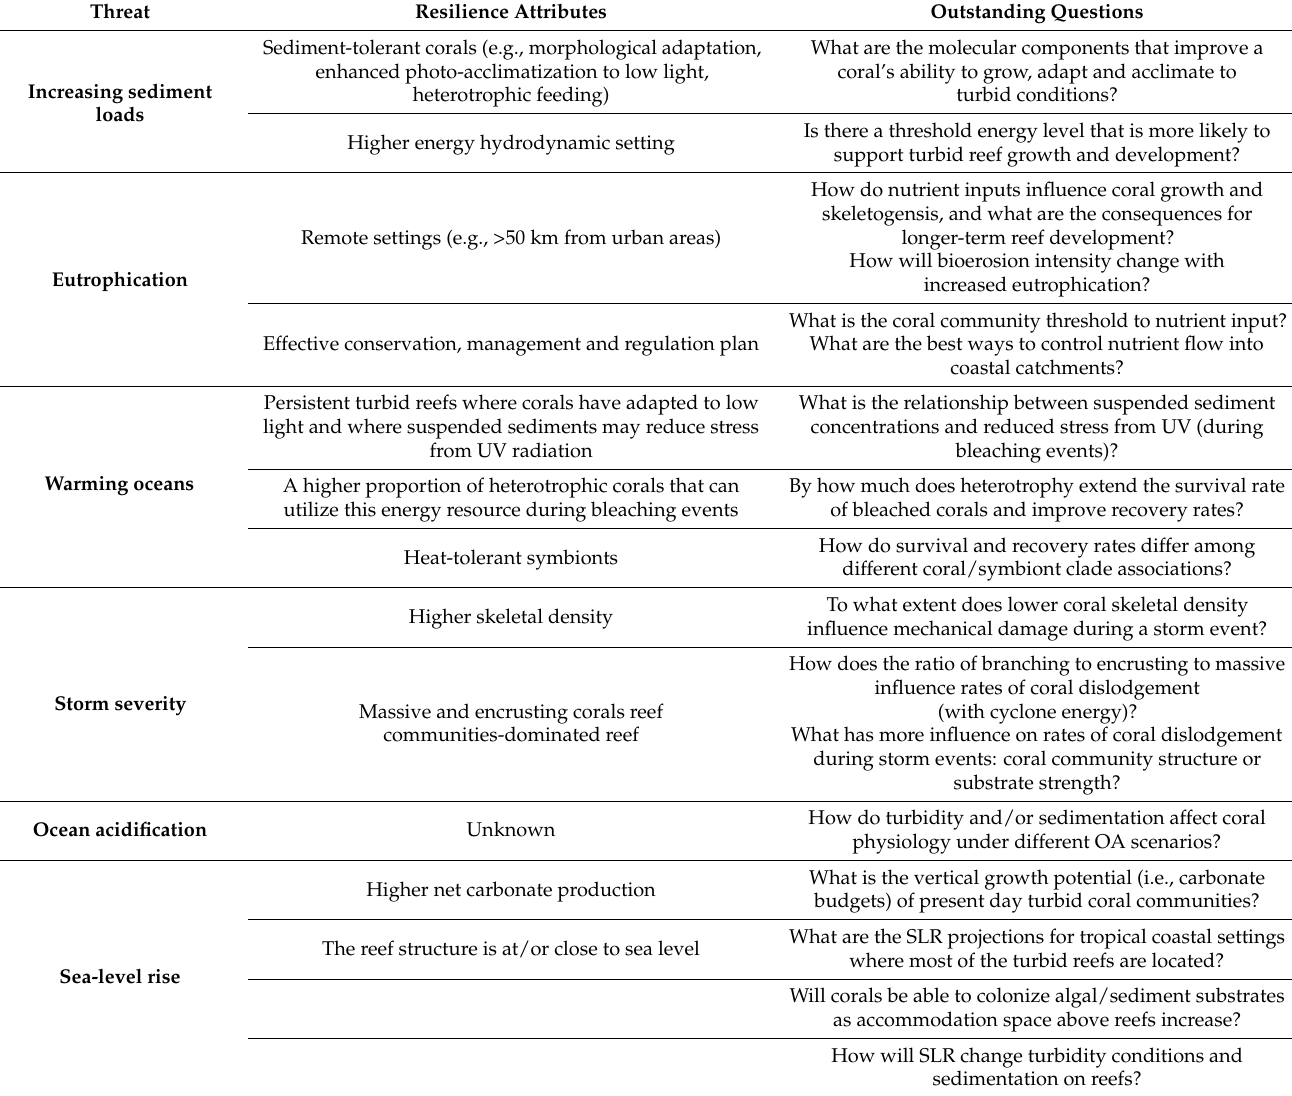
Table 2. Summary of major threats to turbid reefs, potential attributes of resilience and outstanding research questions.